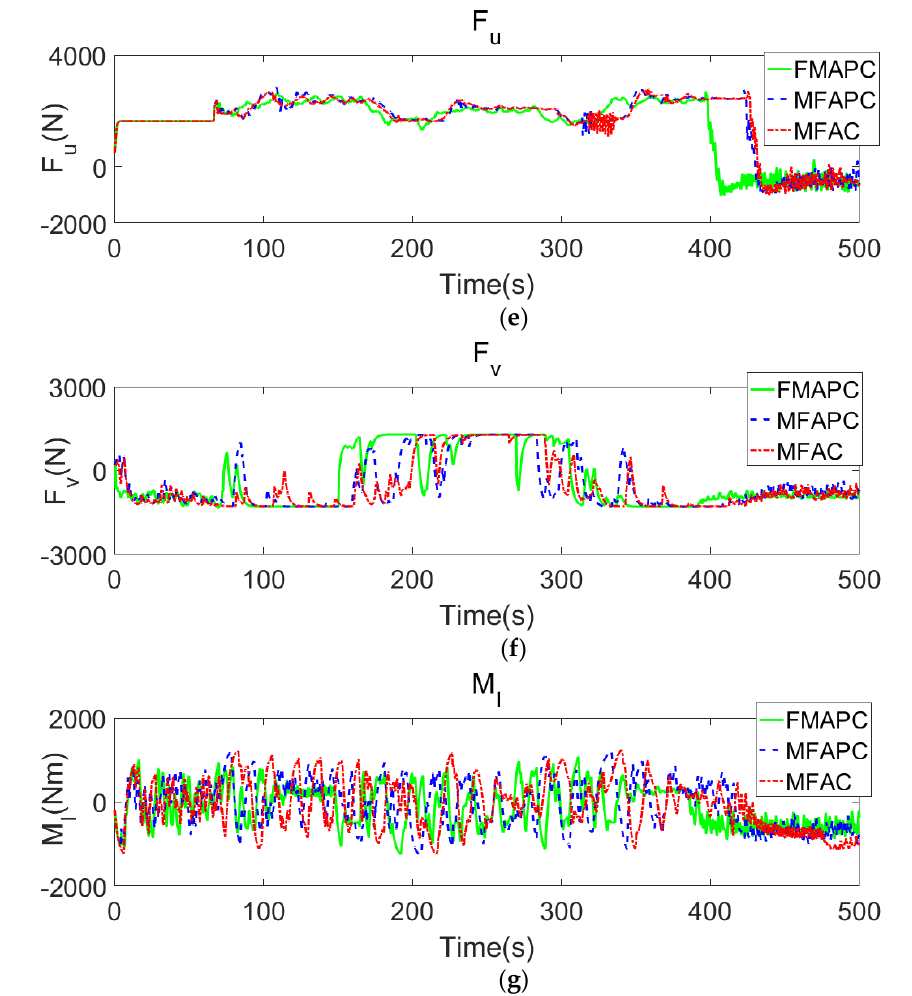
Figure 1. Simulation results of scenario 1. ( a ) Tracking results of comb ‐ shaped trajectory. ( b − d ) Control outputs. ( e − g ) Control inputs.